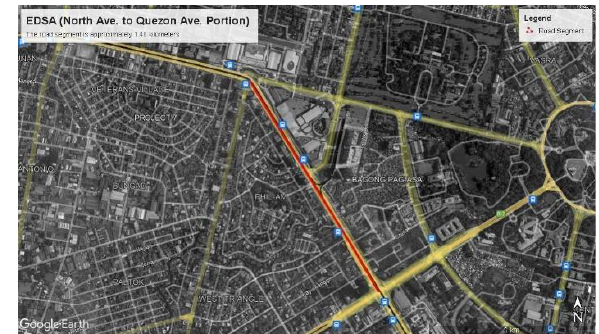
Figure 1. Map of EDSA (North Avenue to Quezon Avenue